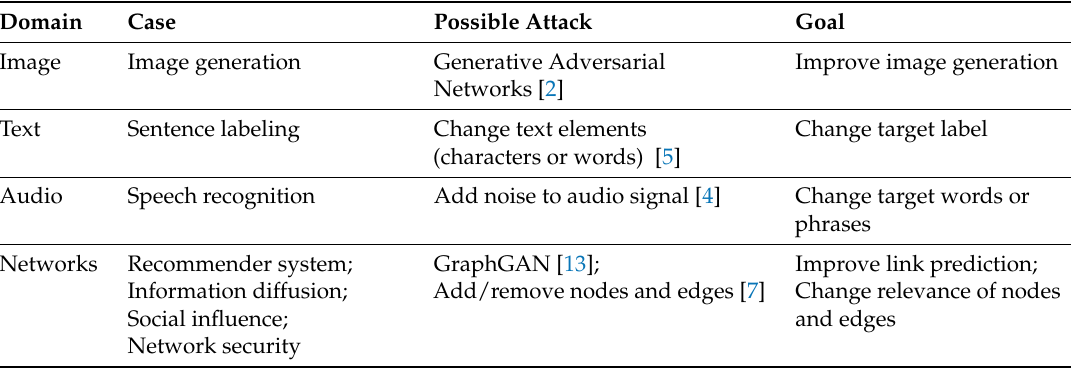
Table 1. Comparison of Adversarial attacks in different domains.